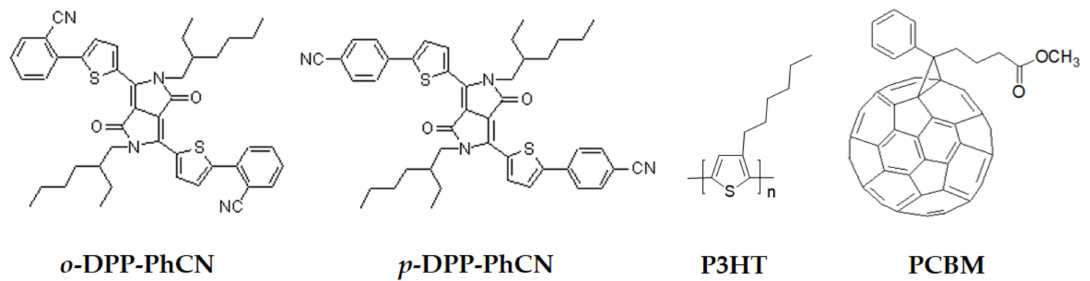
Figure 1. The chemical structures of the o - and p -diketopyrrolopyrrole (DPP)-PhCNs together with poly(3-hexylthiophene) (P3HT) and phenyl-C 61 -butyric acid methyl ester